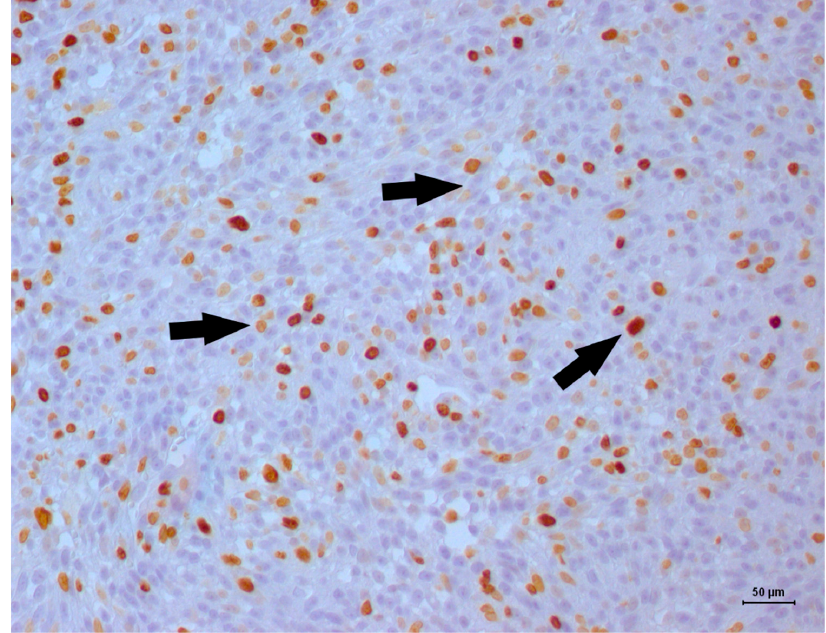
Figure 6. Ki67 immunostaining in a feline bladder leiomyosarcoma. Positive nuclear staining occurred in greater than 50% of the neoplastic cells, which indicated a high proliferative index (black arrows). Harris hematoxylin counterstaining, DAB, original magnification 20×.